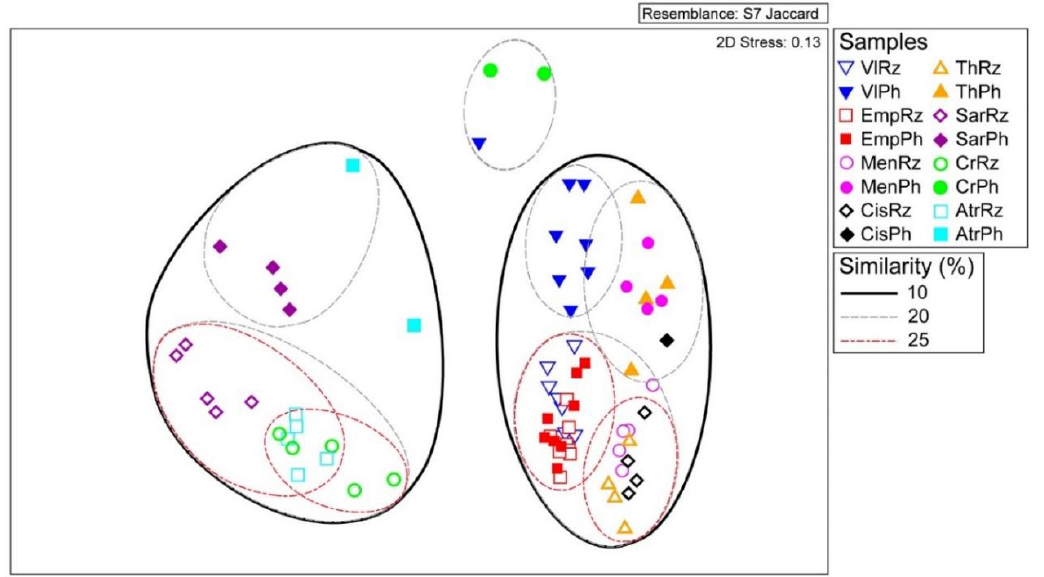
Figure 5. Multidimensional scaling plot of non-transformed OTUs number of reads in all samples (rhizosphere and phyllosphere samples of all individuals sampled), according to Jaccard similarity index. See Table 1 for coding assignments.